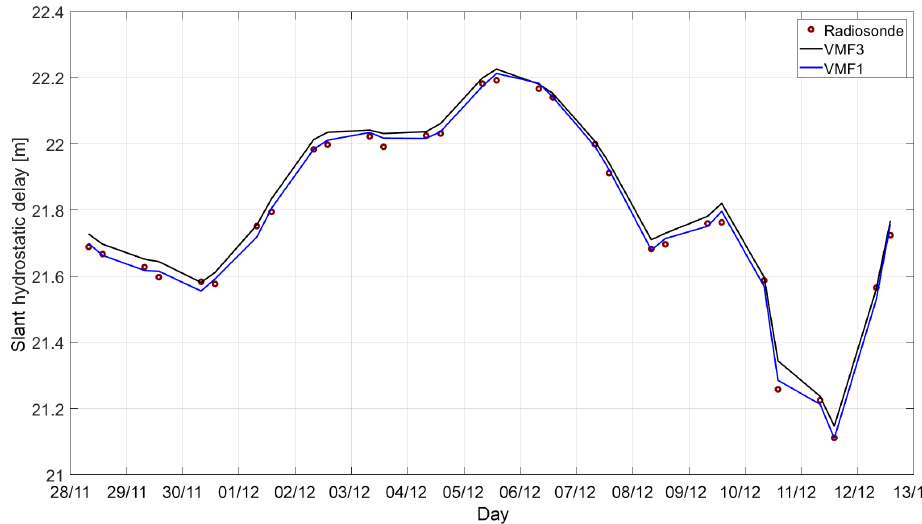
Figure 3. Comparison of slant hydrostatic delays (cid:49)L h at an elevation angle of 5 ◦ at Wettzell.